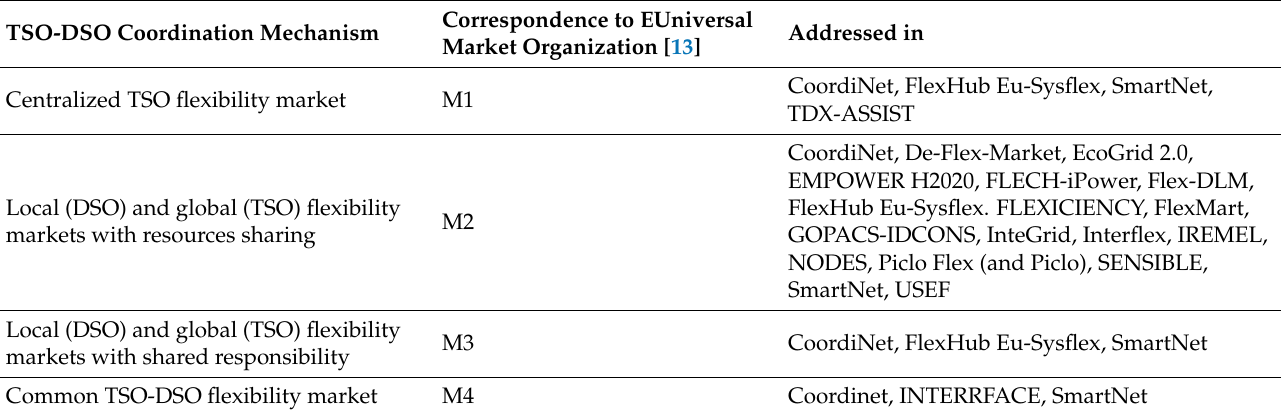
Table 7. Main coordination mechanisms addressed in the initiatives